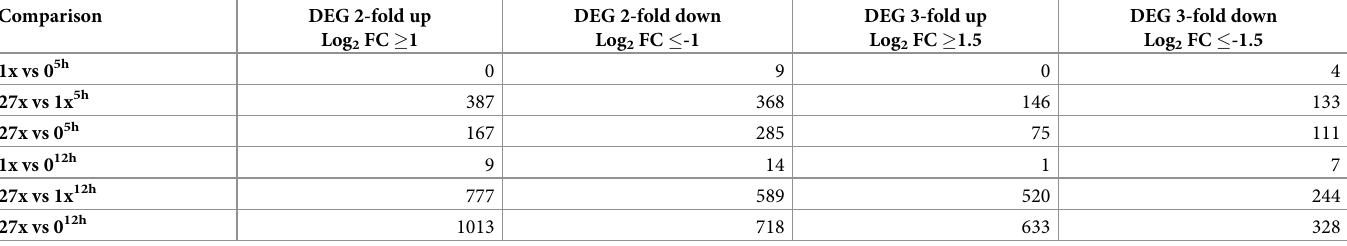
Table 1. Total differential-expressed-genes (DEG) in RNA-Seq comparisons of serotype O157:H7 strain PA20 grown for five hours or 12 hours in LB-NS in the presence of different SMX-TM concentrations as listed.